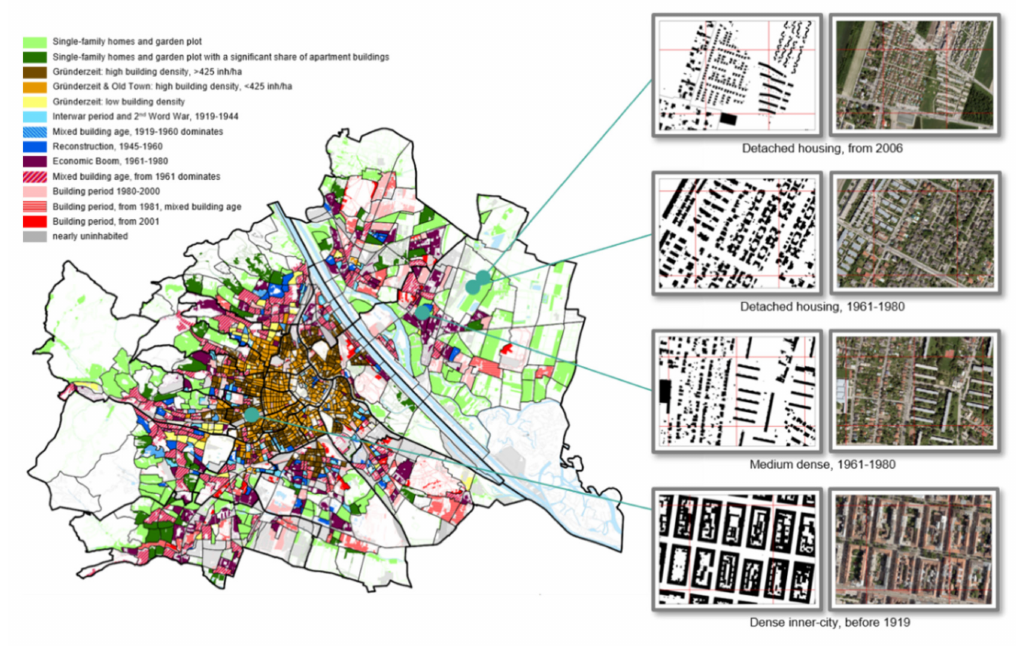
Figure 2. Selected urban typologies (according to